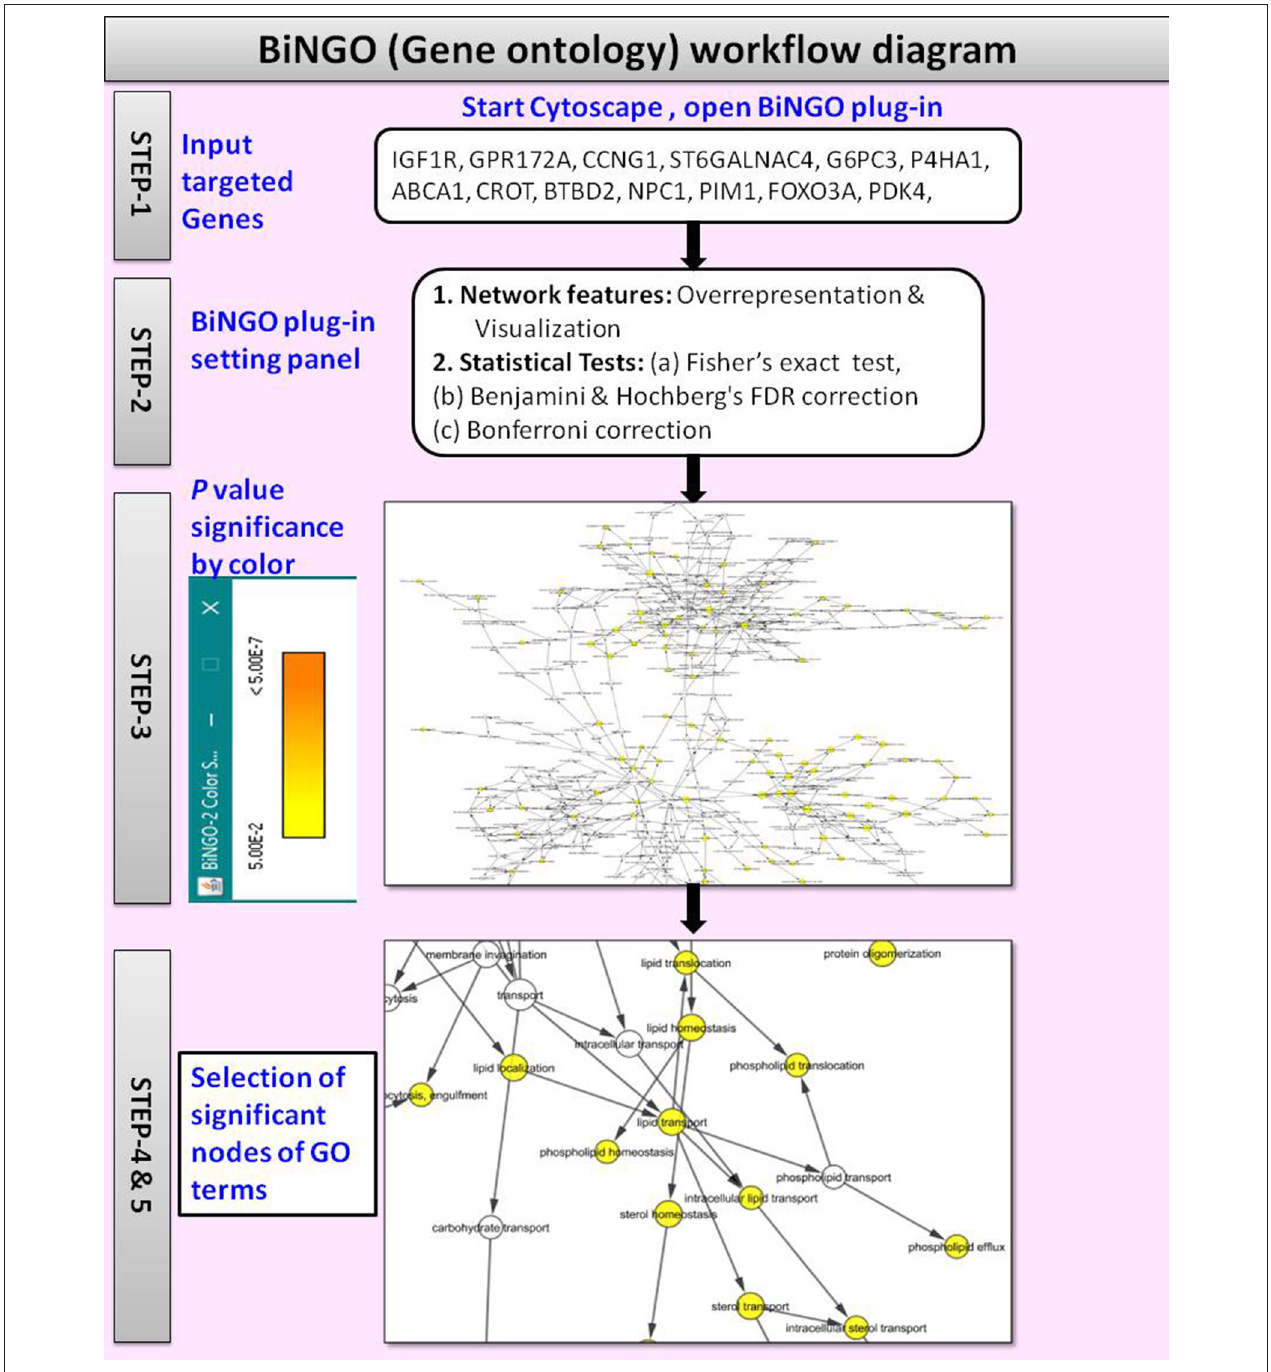
FIGURE 4 | Workflow diagram of BiNGO Gene ontology.